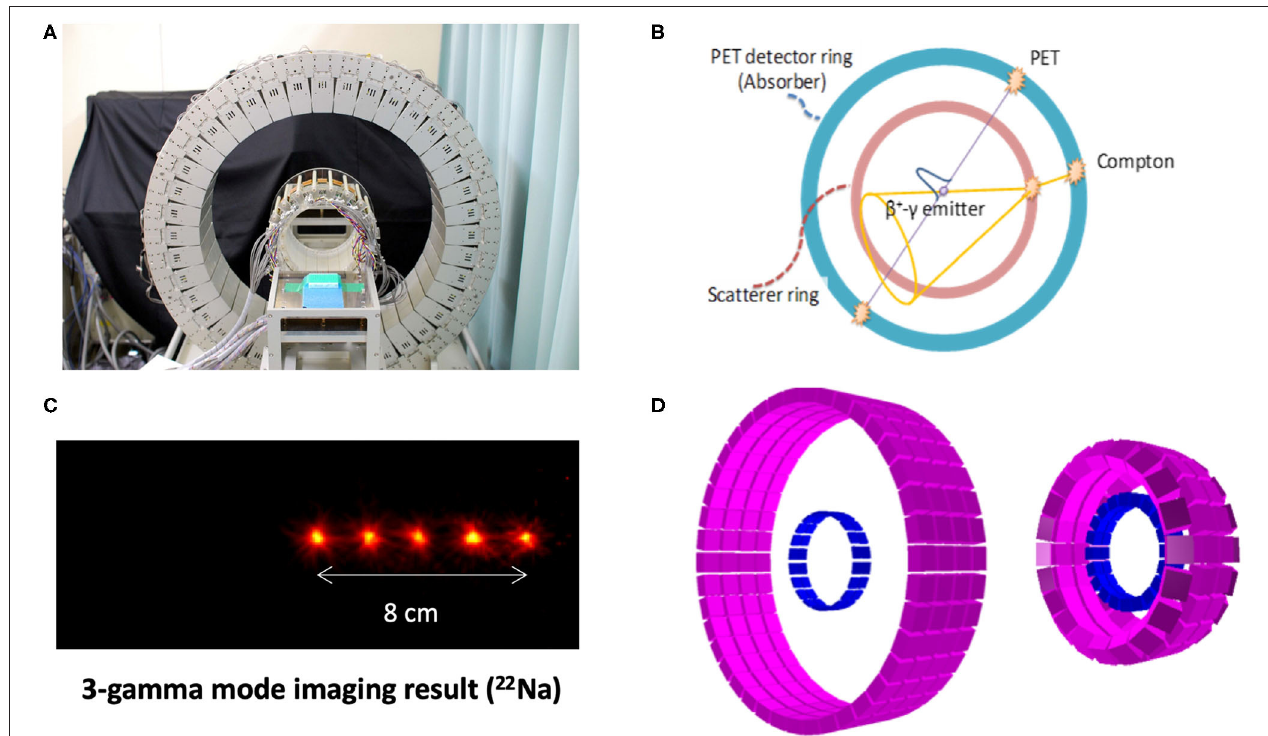
FIGURE 9 | WGI prototype at NIRS (A) for combined PET and Compton imaging (B) , along with its Compton imaging performance for the measurement of 22 Na sources, emitting a positron, and a 1,274 keV photon (C) . Corresponding simulation model (D) for optimization of the design [left: same design as (A) , right: modified design for improved Compton efficiency] (Source: NIRS and